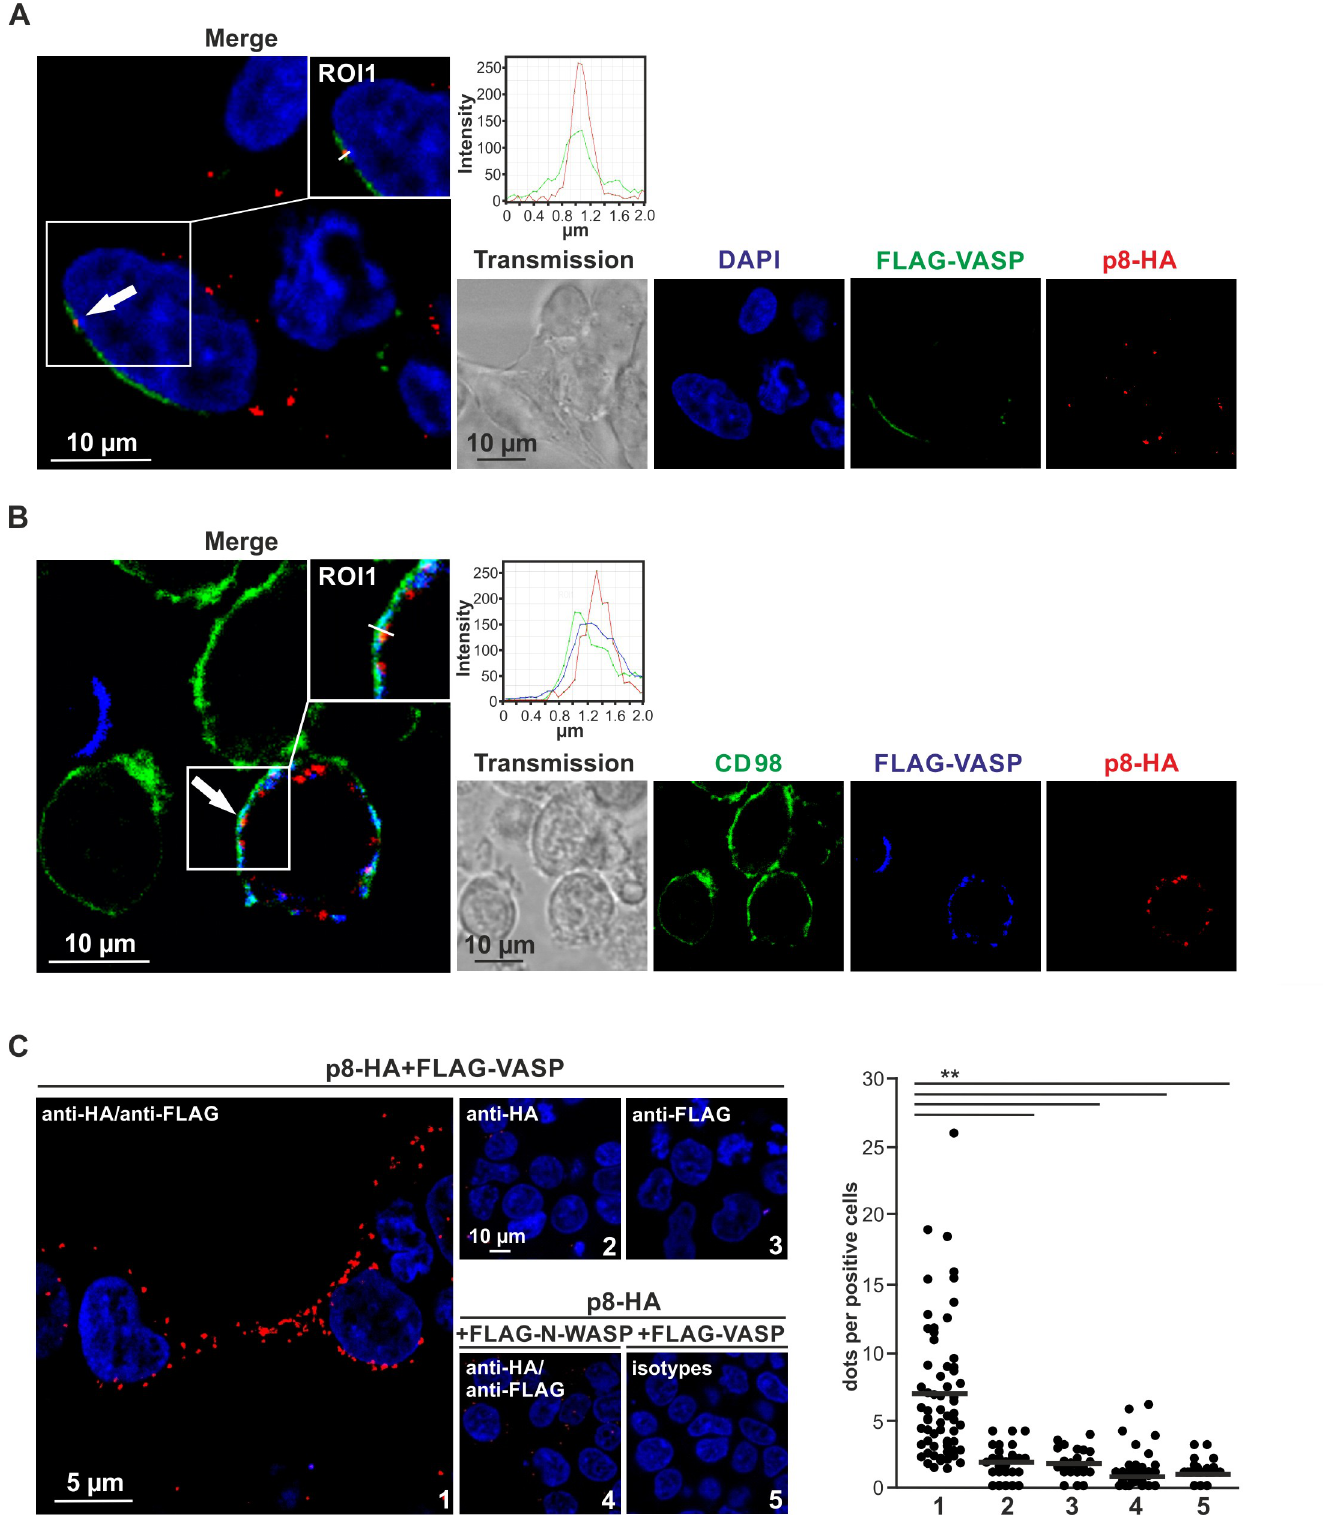
Fig 4. p8 and VASP partially co-localize at the plasma membrane. Confocal laser scanning microscopy of (A) 293T cells (seeded on coverslips), and (B) Jurkat T- cells after co-transfection of p8-HA and FLAG-VASP expression plasmids. (A) Stains of FLAG-VASP (green), p8-HA (red), the cell nucleus (DAPI, blue), the